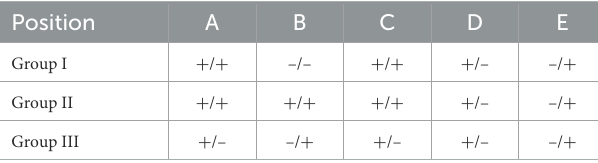
TABLE 1 Contraction of gastrocnemius/tibialis anterior muscles after stimulation of different positions of